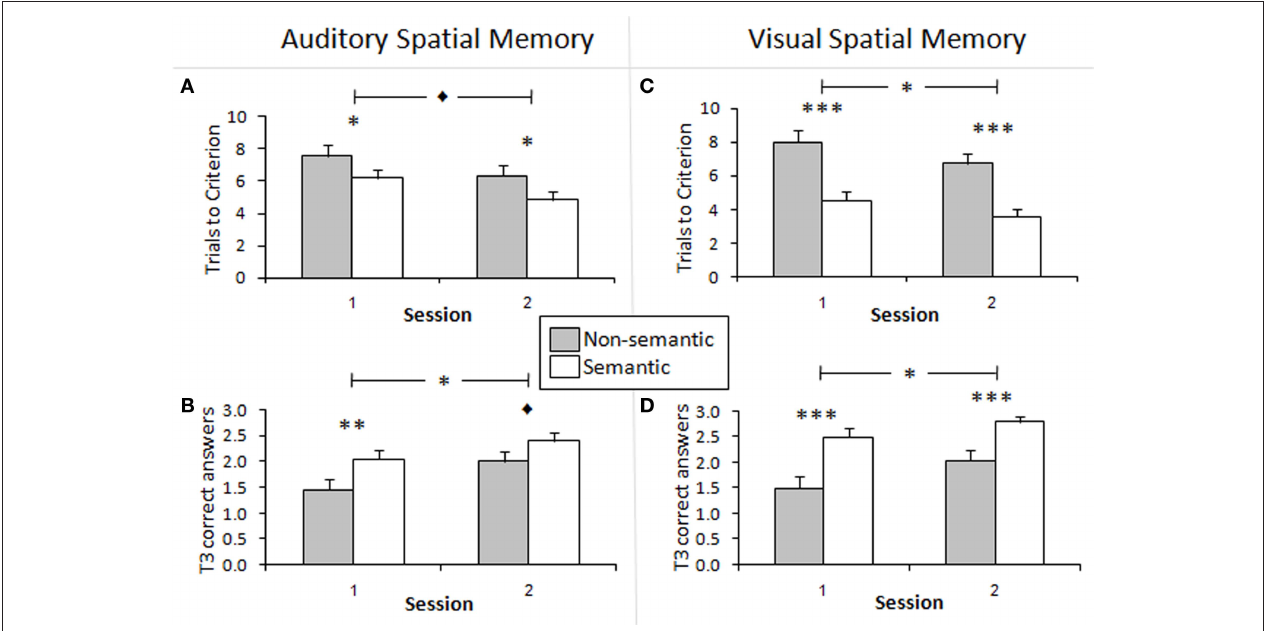
FigurE 3 | Semantic vs. non-semantic learning effects. (A,C) Trials to criterion for spatial recall of non-semantically meaningful and semantically meaningful stimuli. The non-semantic stimuli required significantly more trials to reach criterion in both sessions than the semantic stimuli in the auditory and visual tasks. There was a tendency toward significance for performance to be better in Session 2 than in Session 1 in the auditory task, and this effect was significant in the visual task. (B,D) Mean number of correct